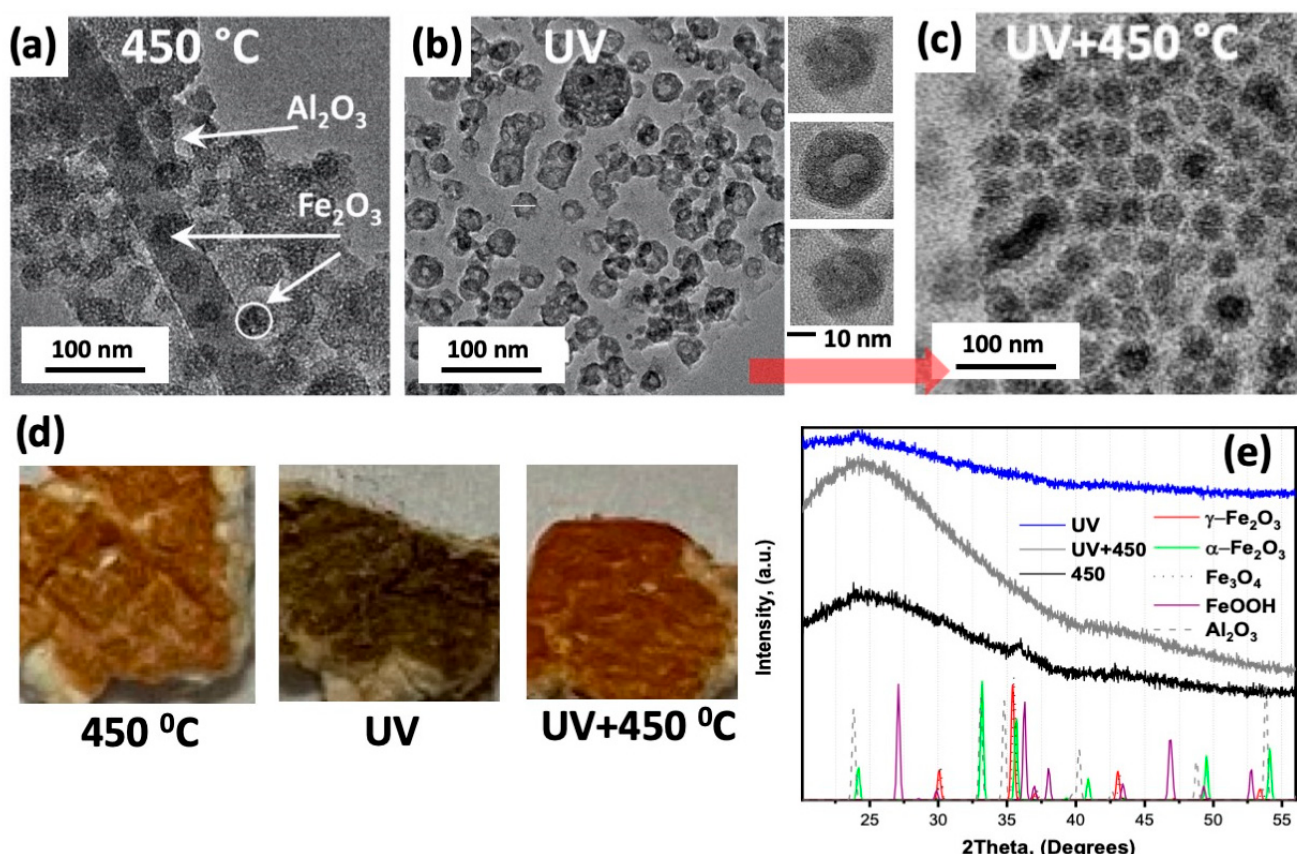
Figure 3. TEM images of the samples after the polymer removal using ( a ) the thermal annealing process at 450 °C, ( b ) UV ozone treatment (the images on the right demonstrate higher resolution TEM images of the representative individual NPs), and ( c ) UV ozone treatment followed by oxidative annealing at 450 °C. ( d ) Photographs and ( e ) XRD data of iron oxide/alumina heterostructures obtained by different polymer removal strategies. The samples shown in ( d ) were deposited on fiberglass for better contrast.